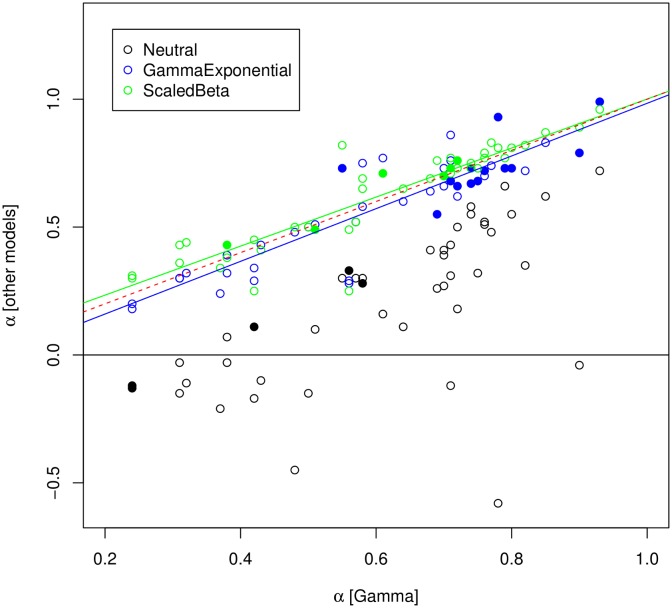
Effect of the underlying DFE model on estimators of α.Each dot is for a species pair. X-axis: estimated α under the Gamma model. Y-axis: estimated α under the Neutral (black), GammaExpo (blue) and ScaledBeta models (red). Dotted red line: (y = x) line. Closed circles indicate species pairs for which the considered model obtained the highest AIC.